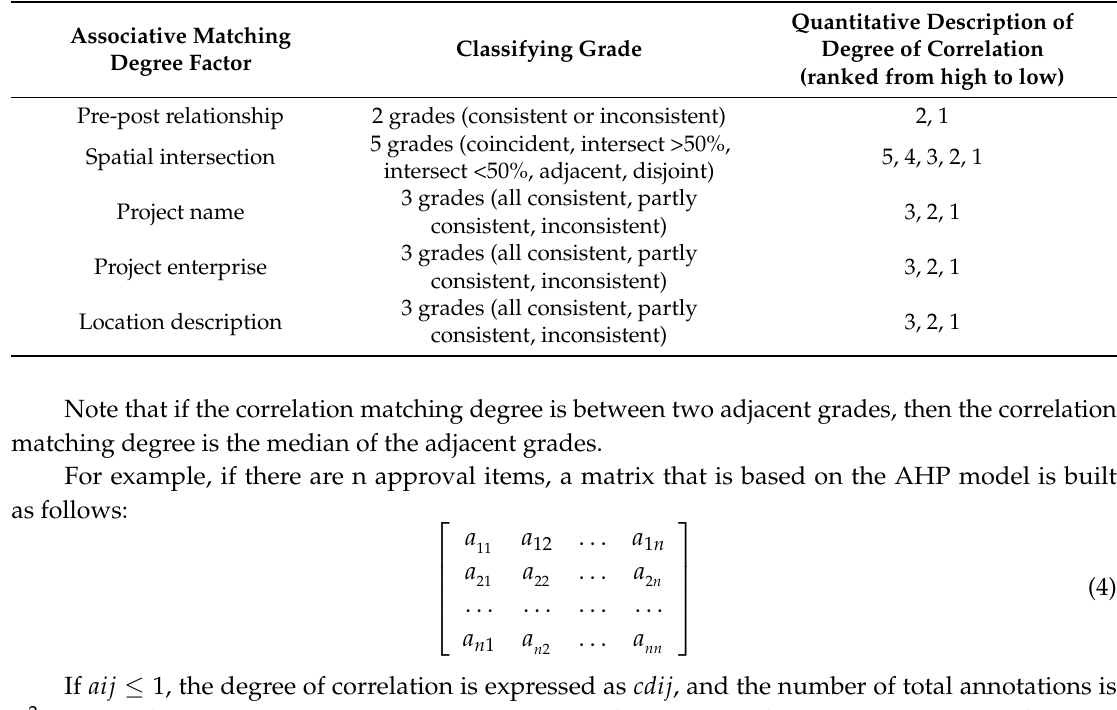
Table 2. Division standards for the degree of correlation of each factor in the criterion